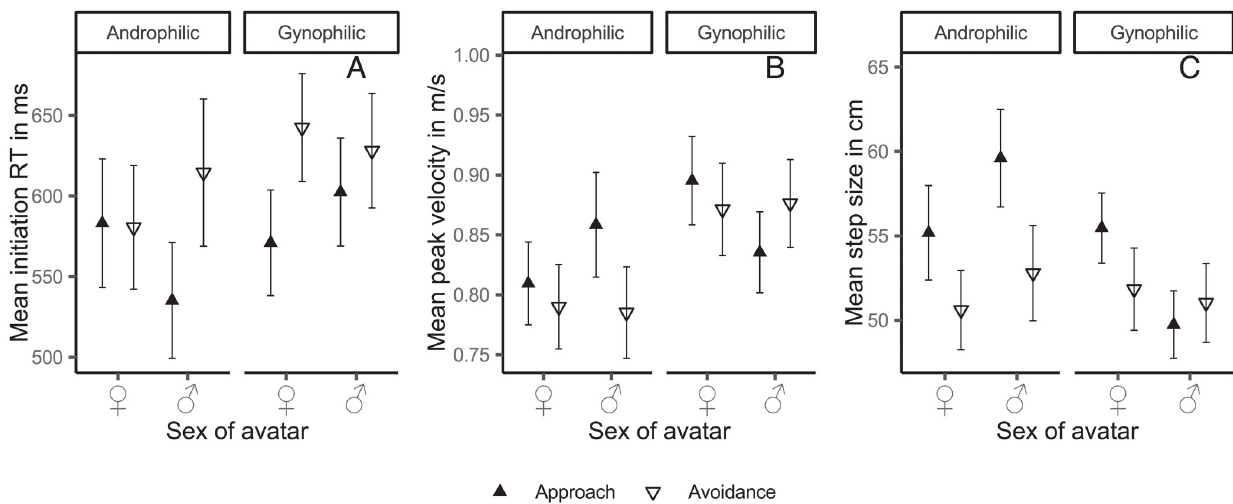
Fig 2. Mean initiation RT (panel A), peak velocity (panel B), and step size (panel C) as a function of sexual orientation, reaction direction, and avatar sex. Error bars denote ± 1 standard error of the mean.